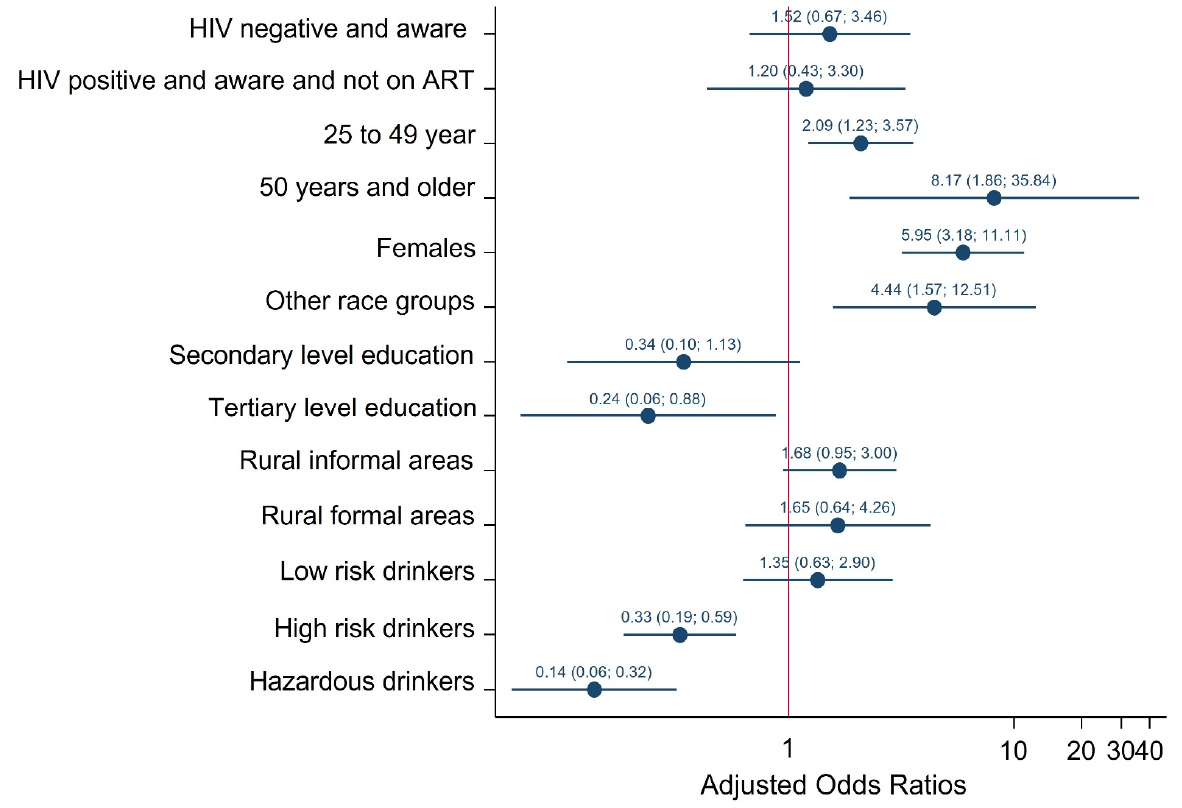
Figure 3. Multivariate logistic model of factors associated with no consistent condom use during their last sexual encounter among individuals 15 years older, South Africa 2017 survey.